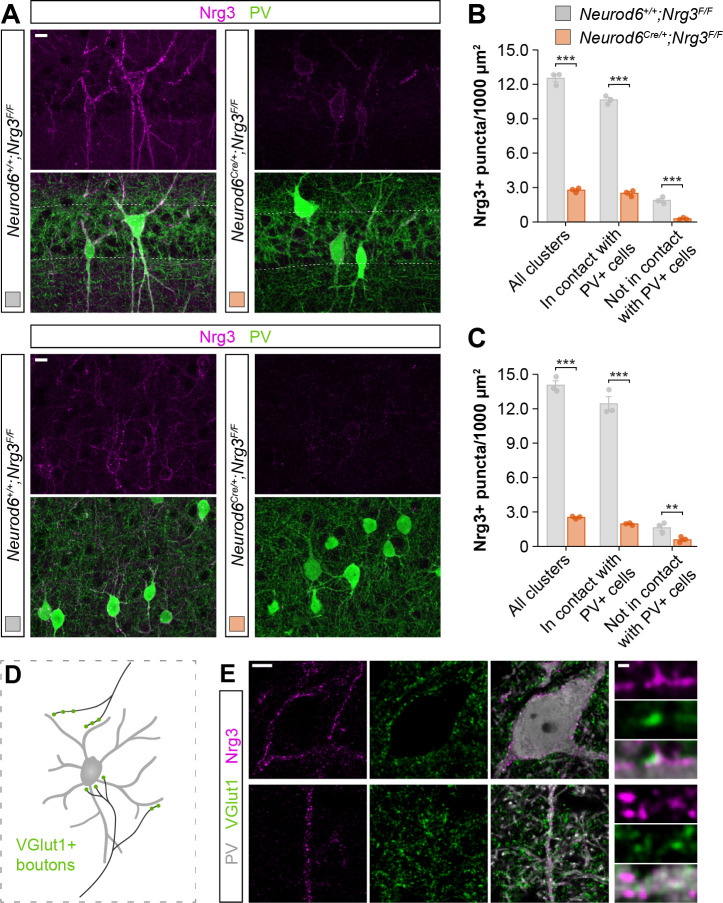
Localization of endogenous Nrg3 in the neuropil of the neocortex, and specific targeting to excitatory presynaptic boutons innervating PV+ interneurons.(A) Coronal sections through CA1 region (top) and cerebral cortex (bottom) of Neurod6+/+;Nrg3F/F and Neurod6Cre/+;Nrg3F/F mice at P30. Sections were processed for immunohistochemistry against Nrg3 (magenta) and PV (green). Endogenous Nrg3 protein is primarily found as a punctate pattern in close apposition to PV+ cell bodies. Note that the conditional deletion of Nrg3 is driven by the transgenic line Neurod6Cre, which only recombines the LoxP site-flanked Nrg3 allele in pyramidal cells. Therefore, Nrg3 expression by PV+ cells can still be appreciated in the neocortex of this conditional KO model. (B) Quantification of the total density of Nrg3+ clusters in regions of interest (ROIs) in the CA1 region of conditional mutant mice and wild-type littermates, and quantification of the density of Nrg3+ clusters in apposition to, or not in contact with, PV+ cell bodies. All clusters: Two-tailed Student’s t-test, ***p<0.001, n = 3 mice (36 ROIs) for Neurod6+/+;Nrg3F/F, n = 3 mice (36 ROIs) for Neurod6Cre/+;Nrg3F/F. In contact with PV+ cells: Two-tailed Student’s t-test, ***p<0.001, n = 3 mice (44 ROIs) for Neurod6+/+;Nrg1F/F, n = 3 mice (36 ROIs) for Neurod6Cre/+;Nrg1F/F. Not in contact with PV+ cells: Two-tailed Student’s t-test, **p<0.01, n = 3 mice (36 ROIs) for Neurod6+/+;Nrg3F/F, n = 3 mice (36 ROIs) for Neurod6Cre/+;Nrg3F/F. (C) Quantification of the total density of Nrg3+ clusters in regions of interest (ROIs) in the cerebral cortex of conditional mutant mice and wild-type littermates, and quantification of the density of Nrg3+ clusters in apposition to, or not in contact with, PV+ cell bodies. All clusters: Two-tailed Student’s t-test, ***p<0.001, n = 3 mice (36 ROIs) for Neurod6+/+;Nrg3F/F, n = 3 mice (36 ROIs) for Neurod6Cre/+;Nrg3F/F. In contact with PV+ cells: Two-tailed Student’s t-test, ***p<0.001, n = 3 mice (36 ROIs) for Neurod6+/+;Nrg1F/F, n = 3 mice (36 ROIs) for Neurod6Cre/+;Nrg1F/F. Not in contact with PV+ cells: Two-tailed Student’s t-test, p=0.269, n = 3 mice (36 ROIs) for Neurod6+/+;Nrg3F/F, n = 3 mice (36 ROIs) for Neurod6Cre/+;Nrg3F/F. (D) Schematic illustrating the synaptic innervation of glutamatergic boutons (labeled with the presynaptic marker VGlut1) onto cortical PV+ interneurons. (E) Co-localization of endogenous Nrg3 (magenta) with VGlut1 (green) within excitatory inputs innervating PV+ interneurons in the neocortex. Scale bar, 10 µm (A), 5 µm (E) and 0.5 µm (high magnifications). Data are shown as mean ± s.e.m. Data used for quantitative analyses are available in Figure 3—figure supplement 2—source data 1.
Figure 3—figure supplement 2—source data 1.Numerical data of puncta density of endogenous Nrg3 protein in the cerebral cortex.